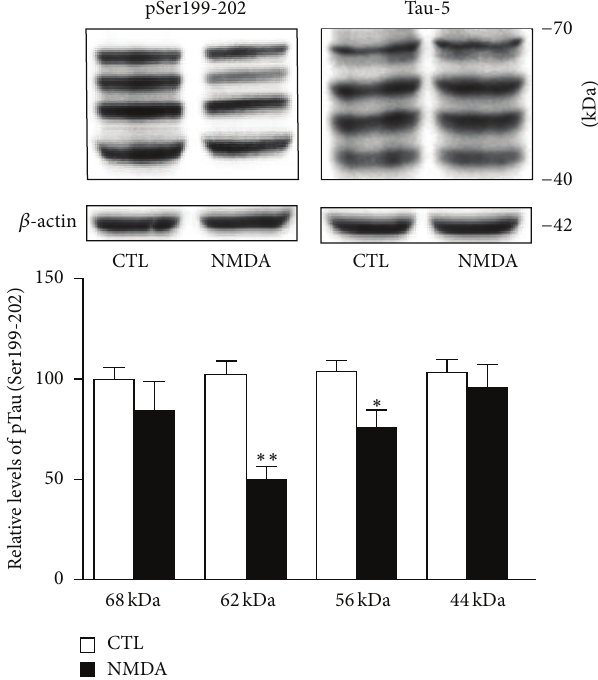
Figure 2: NMDA-induced changes in Tau phosphorylation is isoform-specific. Phosphorylated Tau levels at Ser199-202 were estimated by Western blotting of cell extracts obtained from acute hippocampal slices treated with or without 10 𝜇 M NMDA for 1 hour. Four Tau isoforms were detected in blots developed with antibody directed against Ser199-202. Expressed relative to total Tau (i.e., Tau-5) levels, the data indicate that NMDA-induced reduction of Tau phosphorylation was striking for the 62-kDa isoform and, at a lesser degree, for the 56-kDa isoform. The data are expressed as percentages of control values and are means ± S.E.M. of 3 measurements per cell extract obtained from 8 different rats. Since each isoform was investigated independently, statistical significance was determined by unpaired t -test. ∗ 𝑃 < 0.05 , ∗∗ 𝑃 < 0.01 , NMDA- treated versus respective